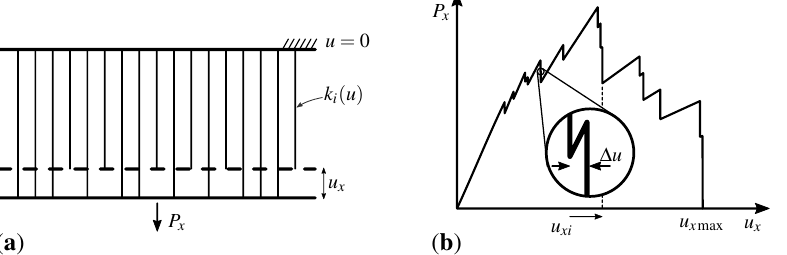
Figure 5. The Bundle Model. ( a ) Parallel bar model where a prescribed displacement u x is applied and the reaction P x is measured, ( b ) evolution of the load during the damage process in typical Bundle Model.